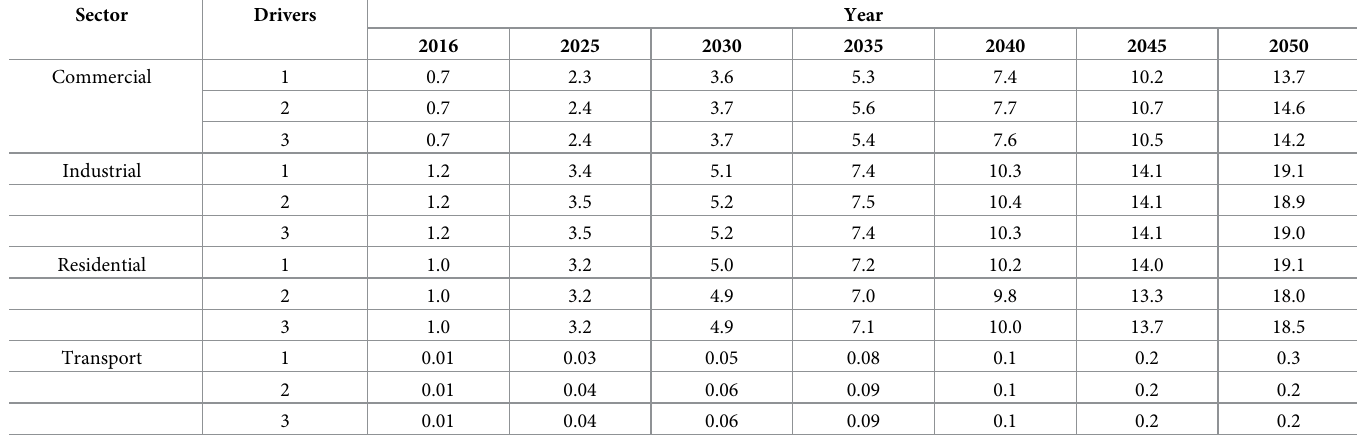
Table 9. Energy consumption (10 3 GWh) for sectors.